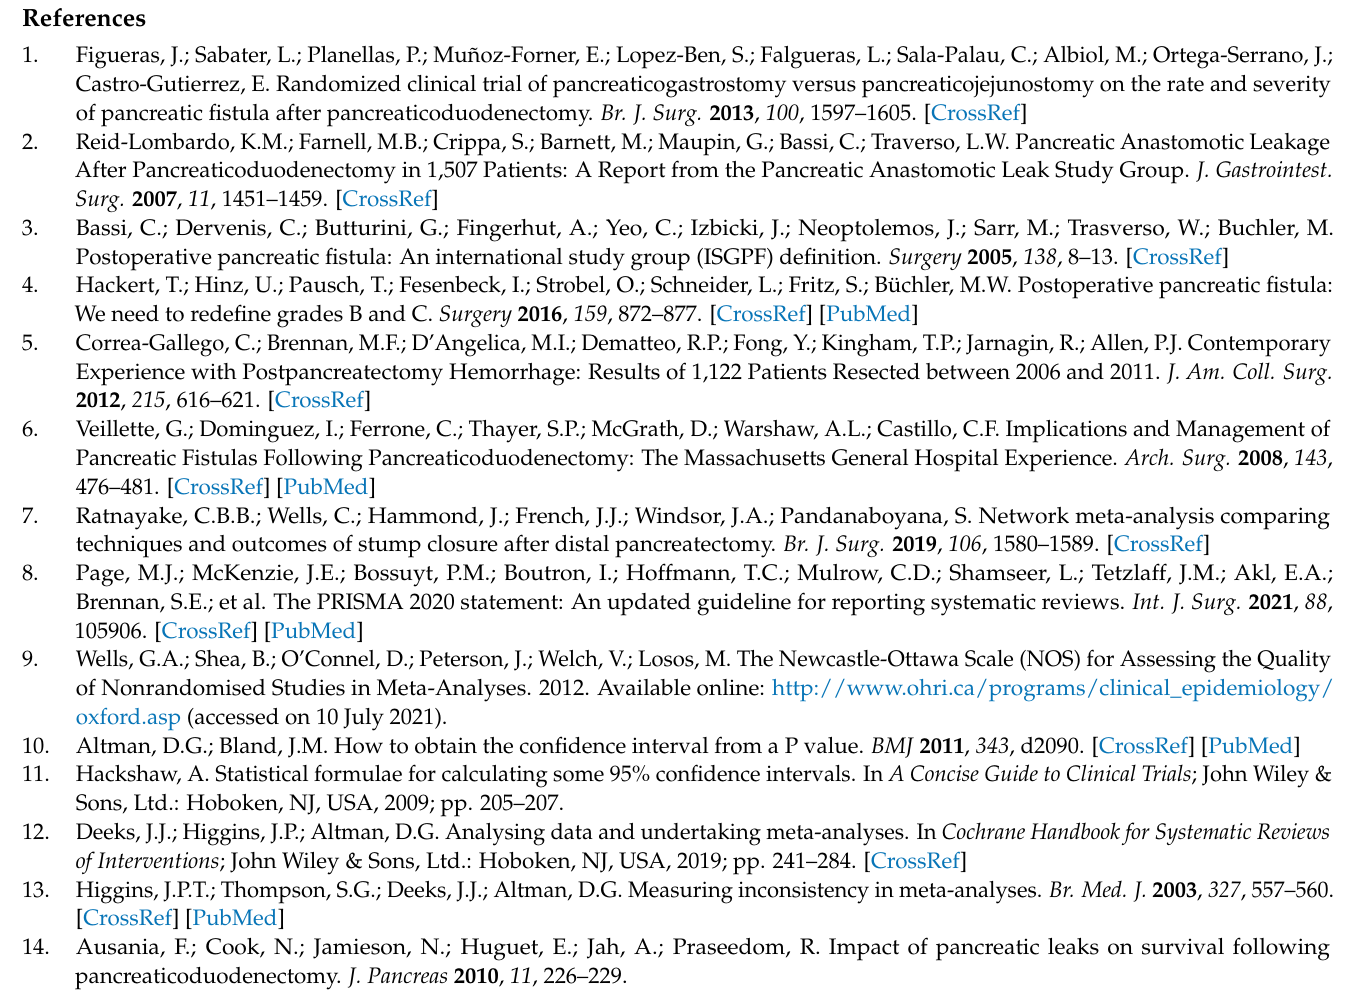
review; Table S3: Disease-free survival: hazard ratios and 95% confidence intervals for patients with/without pancreatic fistula; Table S4: Overall survival: hazard ratios and 95% confidence intervals for patients with/without pancreatic fistula; Table S5: Detailed scores on the Newcastle– Ottawa scale for each cohort study